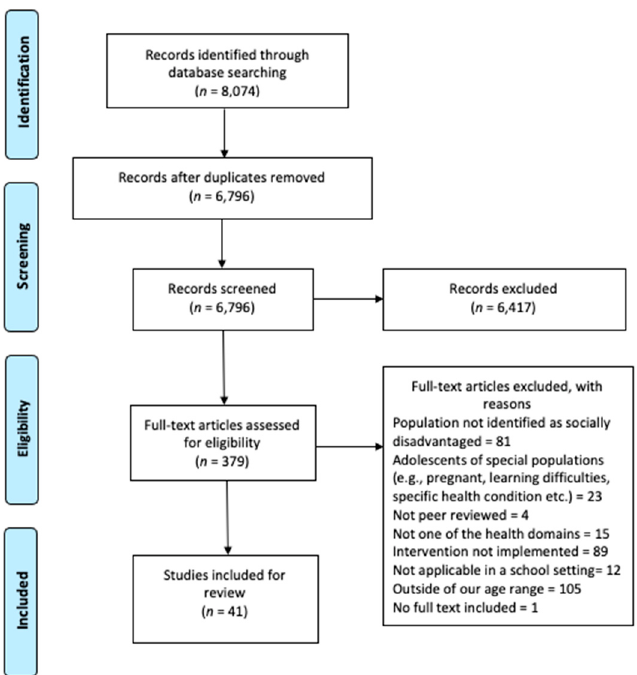
Figure 1. PRISMA Flow Diagram.